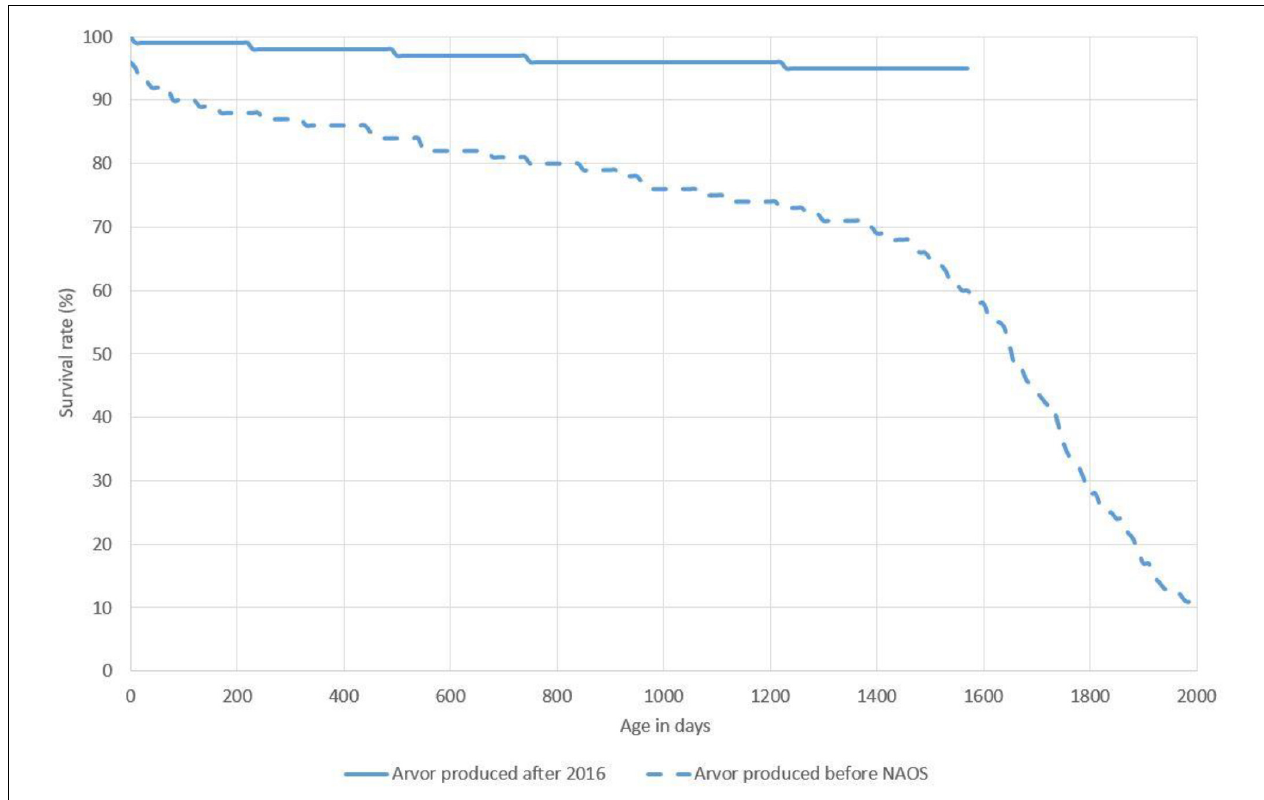
FIGURE 11 | Survival rate of the Arvor profiling float. After 1,000 days at sea, 96% of the Arvor “after NAOS work” (i.e., produced after 2016, depending on the serial number) are still in operation, compared with 76% of the Arvor “before NAOS work” (produced and deployed from 2013 to 2016). Source: www.jcommops.org,